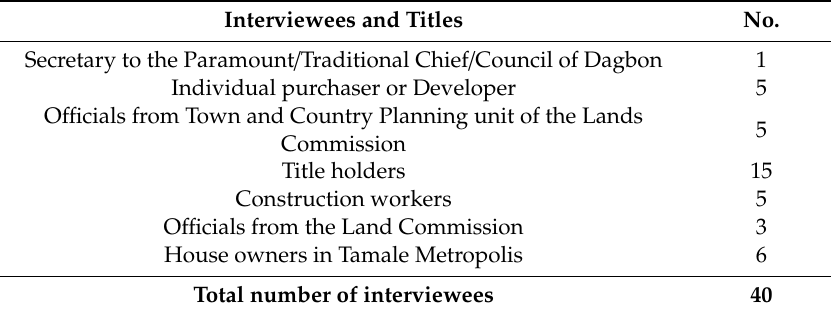
Table 1. The breakdown of people interviewed in the survey and their titles / roles. Interviewees and Titles